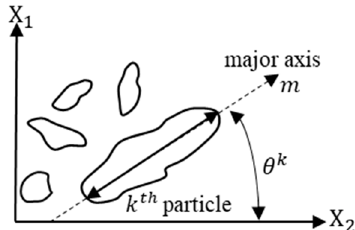
Figure 11. Two-dimensional particles orientation for micromechanics modeling (orientation, 𝜃 and vector, m ).